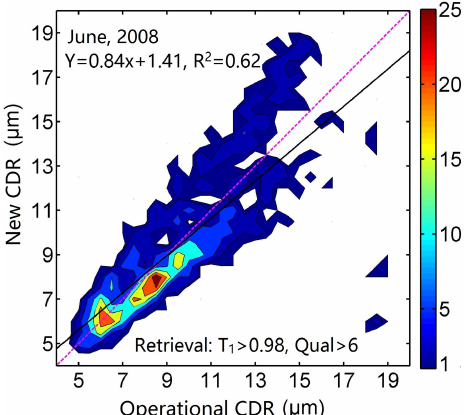
Figure 8. Comparisons between the CDRs estimated from our method and the operational procedure. The global POLDER L1B data in June 2008 were used, where the 1 : 1 line and the regres- sion line are denoted by the magenta dashed line and the black solid line, respectively. The results were determined using the following criteria: T 1 >0.98 and